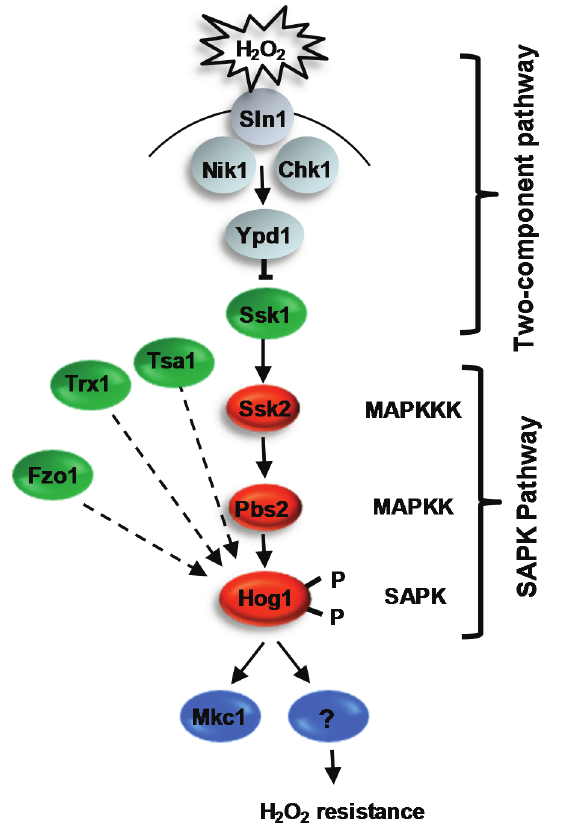
Figure 2. H 2 O 2 -induced activation of the Hog1 SAPK. In response to H 2 O 2 , Hog1 becomes rapidly phosphorylated and accumulates in the nucleus, and C. albicans cells lacking Hog1 are sensitive to oxidative stress. Proteins required for H 2 O 2 -induced activation of Hog1 are shown in green. These include the response regulator Ssk1 (but no other two-component protein), the redox sensitive antioxidants Tsa1 and Trx1, and the mitochondria biogenesis factor Fzo1. Following H 2 O 2 -induced activation, Hog1 phosphorylates the Mkc1 MAPK. However, cells lacking Mkc1 are not sensitive to oxidative stress, suggesting that an, as yet, unknown Hog1 substrate(s), mediates oxidative stress